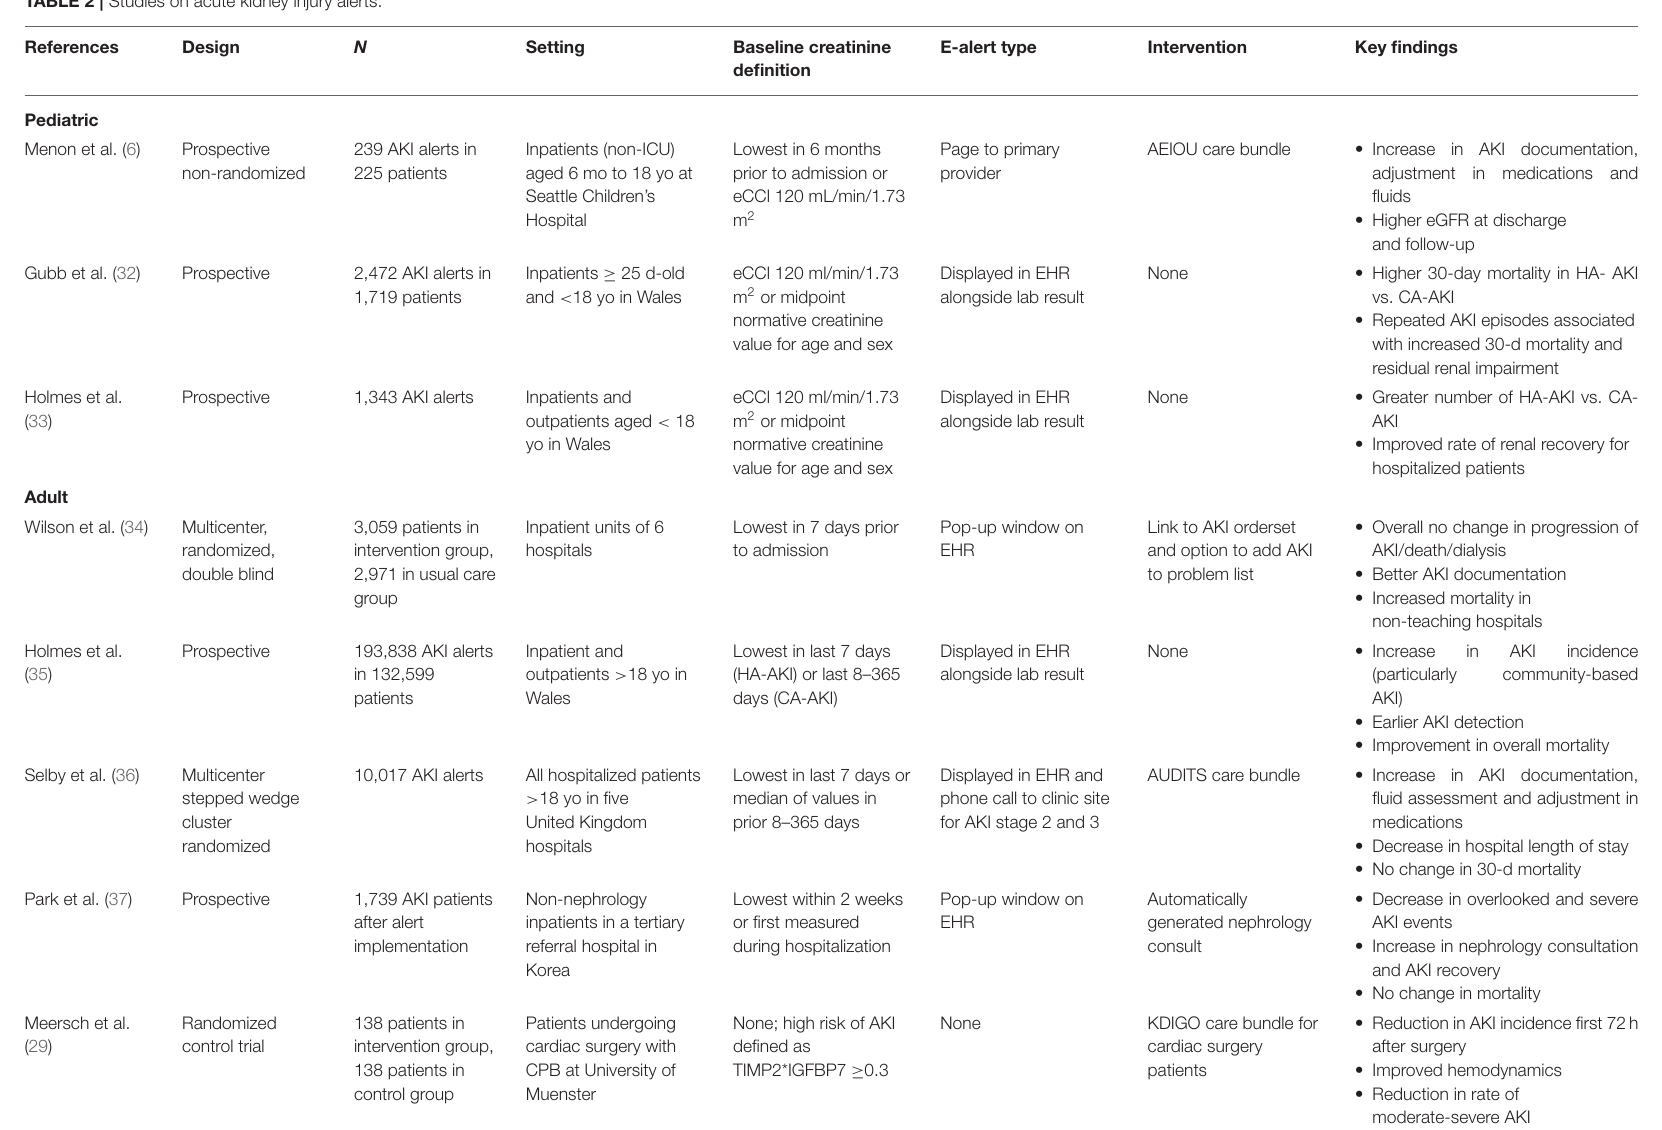
TABLE 2 | Studies on acute kidney injury